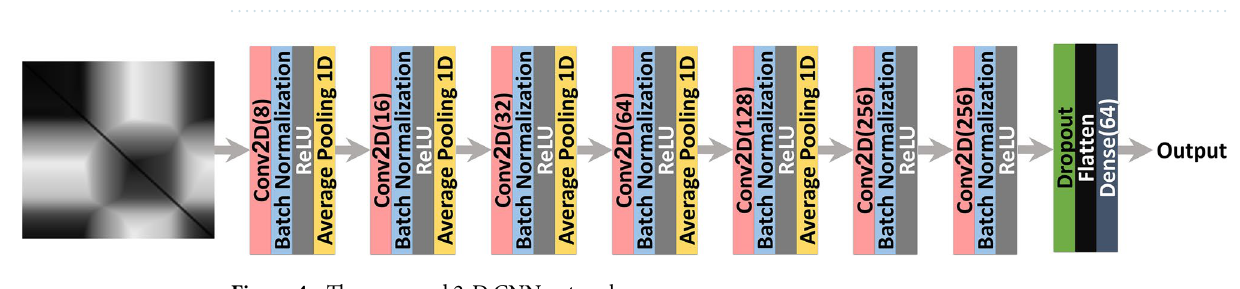
Figure 4. The proposed 2-D CNN